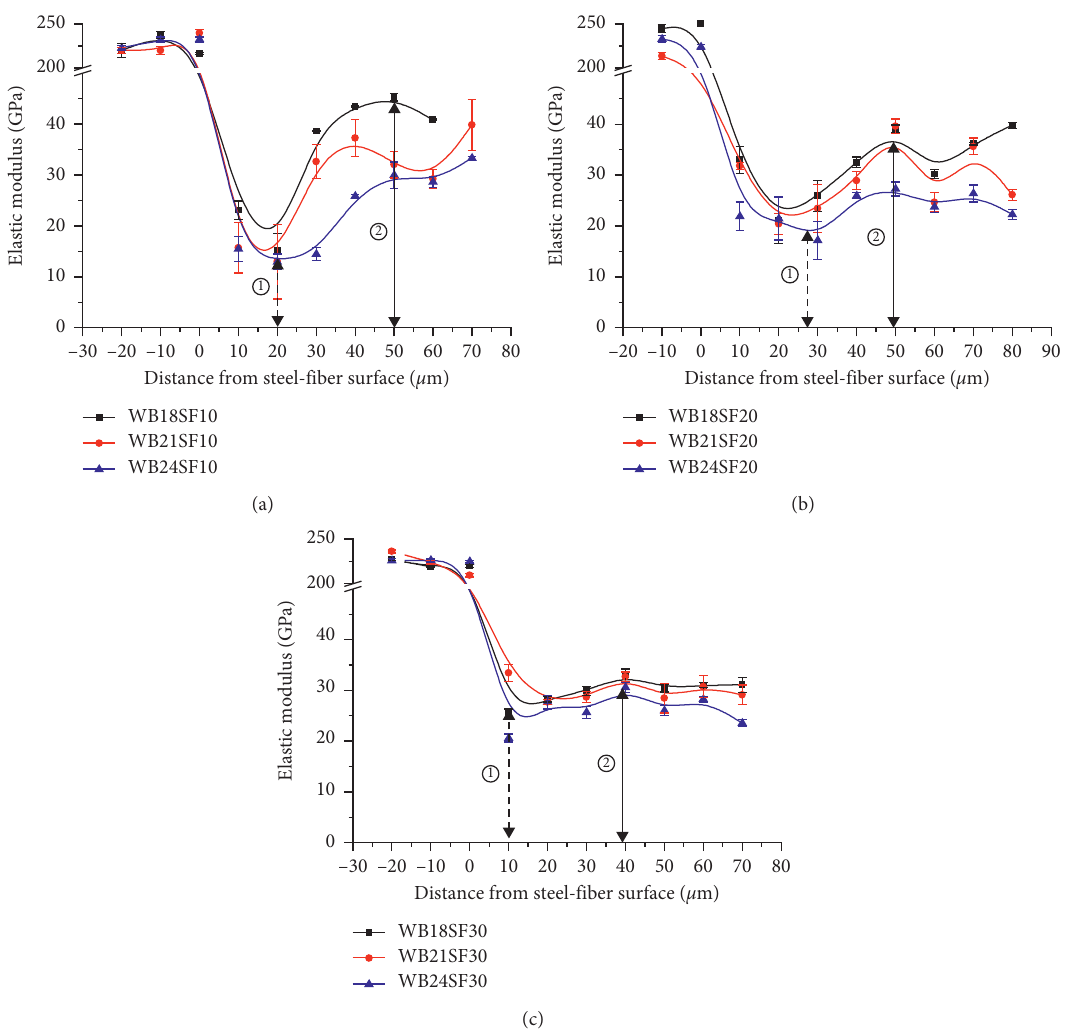
Figure 6: Elastic modulus with distance from the steel-fiber surface for different silica fume contents. (a) Silica fume content of 10%. (b) Silica fume content of 20%. (c) Silica fume content of